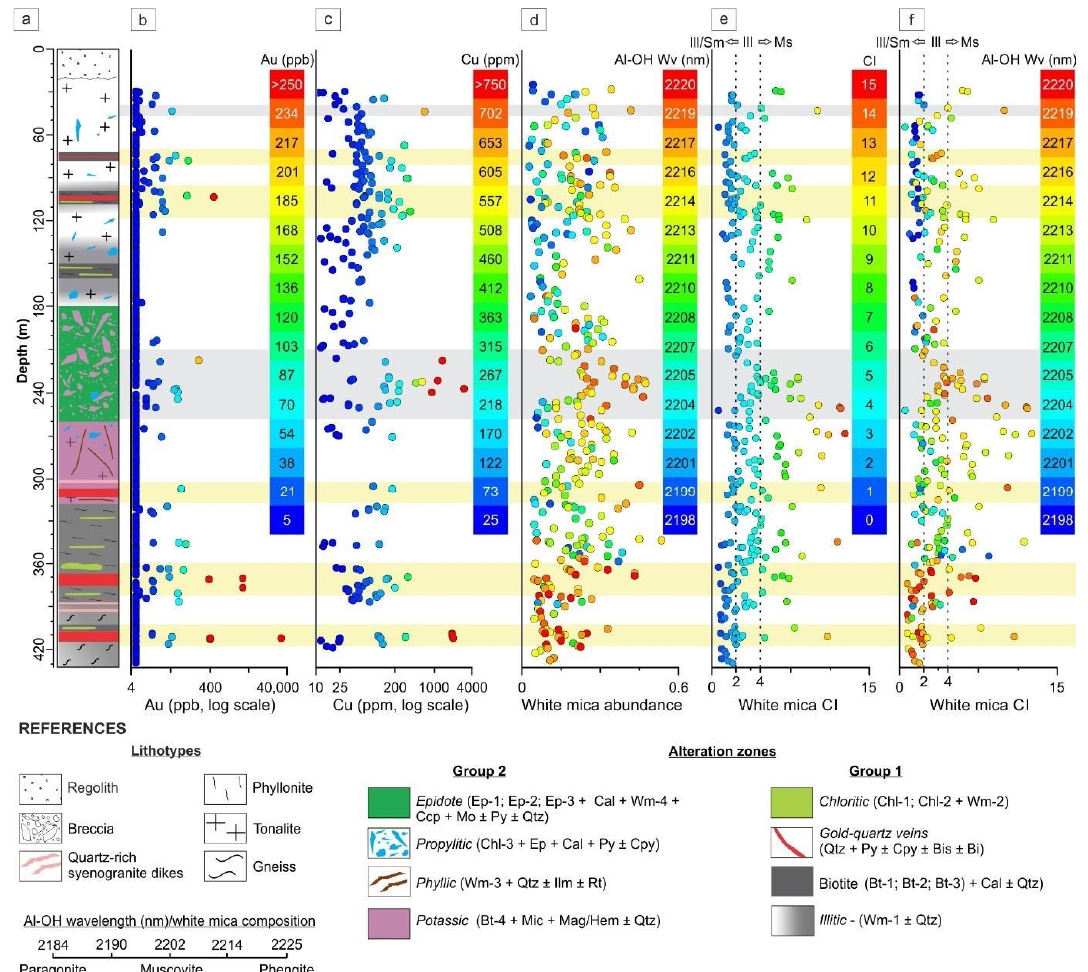
Figure 11. Key features of the Paraíba deposit borehole BH04, integrating: ( a ) one-dimensional striplog, with geological and hydrothermal alteration core logging; ( b ) Au and ( c ) Cu contents (logarithmic scales); ( d ) white mica abundance (with white mica composition wavelengths in auxiliary colors); ( e ) white mica crystallinity (CI); and ( f ) white mica crystallinity (CI) with white mica composition wavelengths in auxiliary colors. The main lithotypes and hydrothermal alteration zones are from Figures 3 and 4. The figure caption shows the complete mineral association described for each alteration zone derived from petrography, core logging, reflectance spectra, and SisuCHEMA. Pale-yellow horizontal levels show high Au content, pale-grey levels show high Cu content, and white background between grey and pale-yellow are barren.